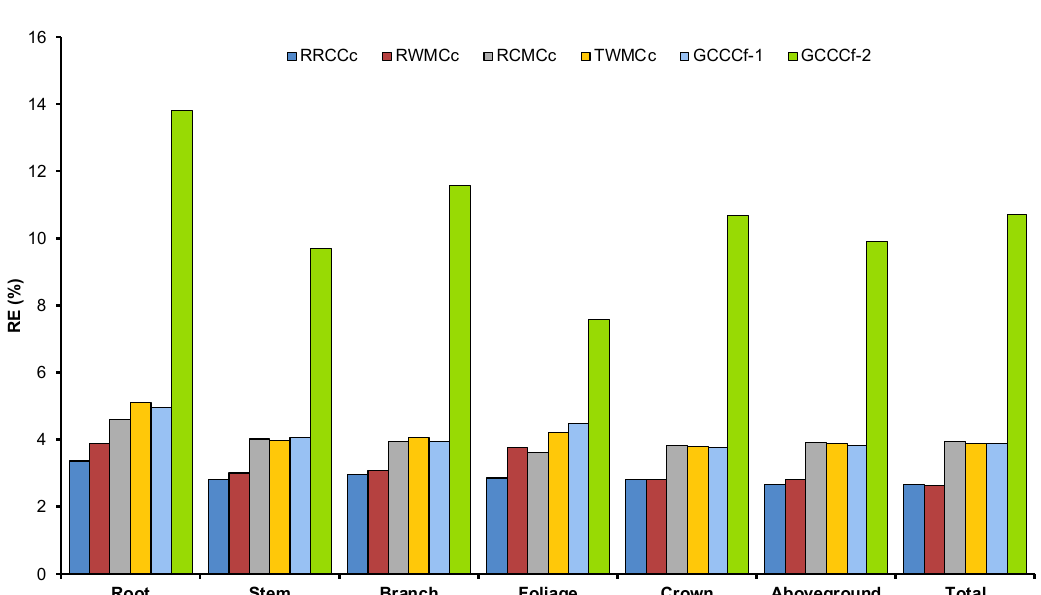
Figure 6. The relative error (RE) of individual tree biomass carbon stock quantified by six different procedures. Regional Respective Component Carbon concentration (RRCCc), Regional Weighted Mean Carbon concentration (RWMCc), Respective Component Mean Carbon concentration (RCMCc), Total Weighted Mean Carbon concentration (TWMCc), Generic Carbon Concentration Conversion factor–1 (GCCCf-1), and Generic Carbon Concentration Conversion factor–2 (GCCCf – 2).